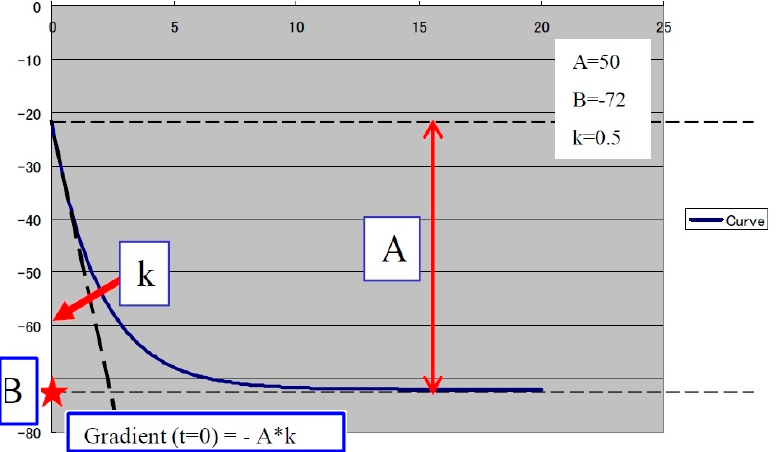
Figure 3. The curve fitting for washout: F(t) = Aexp( − kt) + B, as explained in the graphic above, where exp( − kt): decreasing function for “washout”. For a larger k, the intensity decreases quickly. B: the minimum intensity at t = infinity. The gradient at t = 0 was calculated using “ − A*k”. A is the difference between B and the intercept intensity at t = 0. MSE: mean square error between the actual data and the fitting curve.